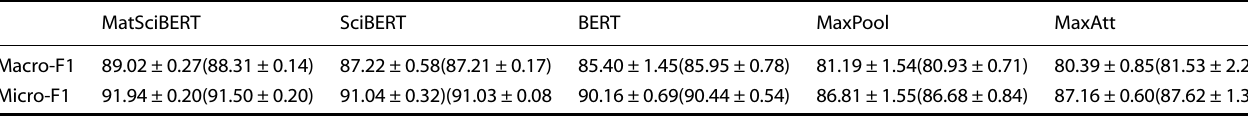
Values in the parenthesis represent the results on the validation set.